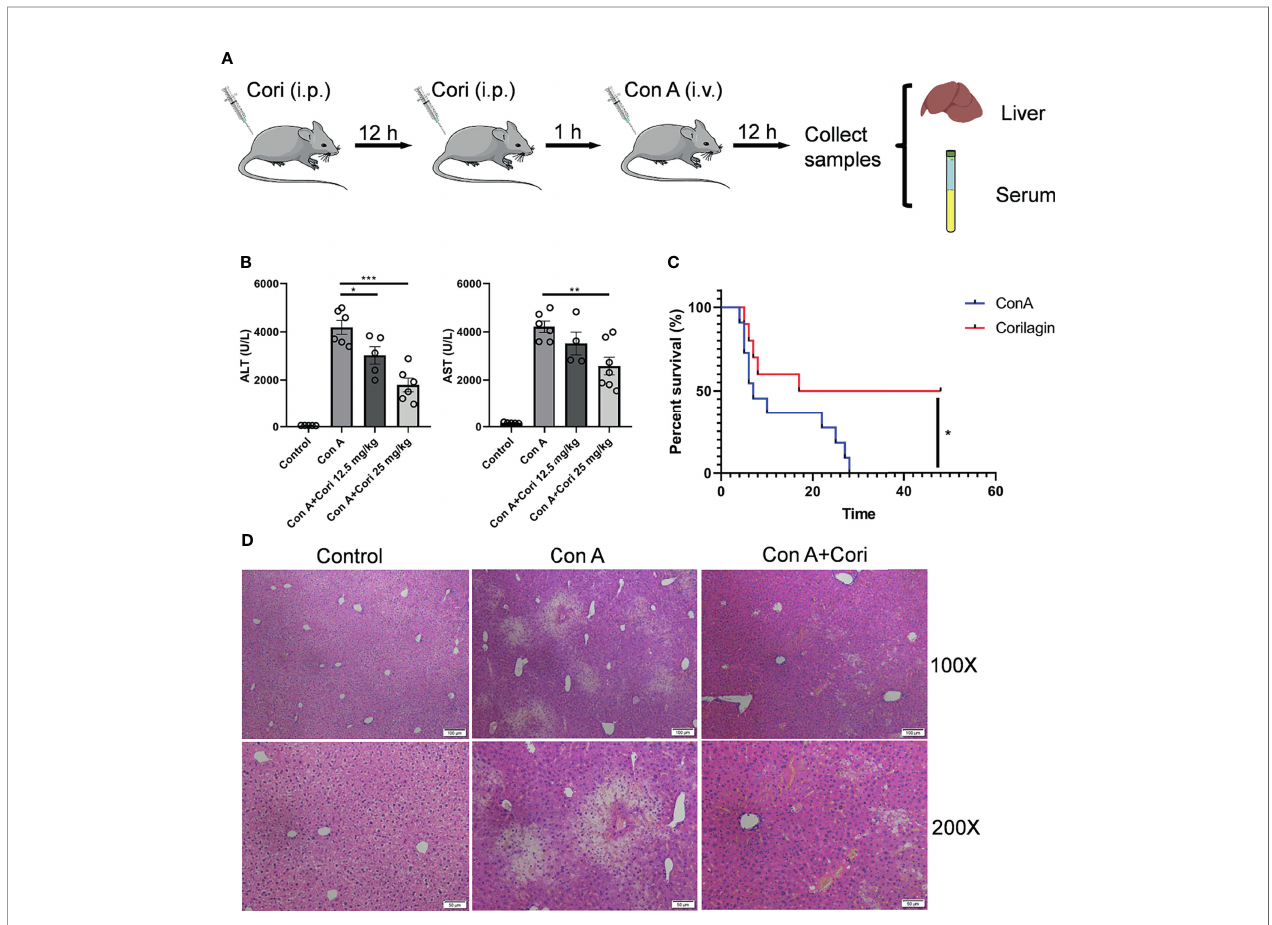
FIGURE 1 | Corilagin ameliorates Con A-induced hepatic injury. Mice were administered with corilagin (12.5, 25 mg/kg) intraperitoneally twice at time intervals of 12 h. After 1 h, mice were challenged with Con A (20 mg/kg body weight). After 12 h, serum and livers were collected. (A) Flowchart for drug administration. (B) Serum alanine aminotransferase (ALT) and aspartate aminotransferase (AST) levels. (C) Survival experiments performed with mice treated with a lethal dose of Con A (25 mg/kg body weight; n = 10). (D) Liver sections stained with hematoxylin and eosin (H&E). Original magni fi cation, 100× and 200×. *p < 0.05, **p < 0.01, ***p <